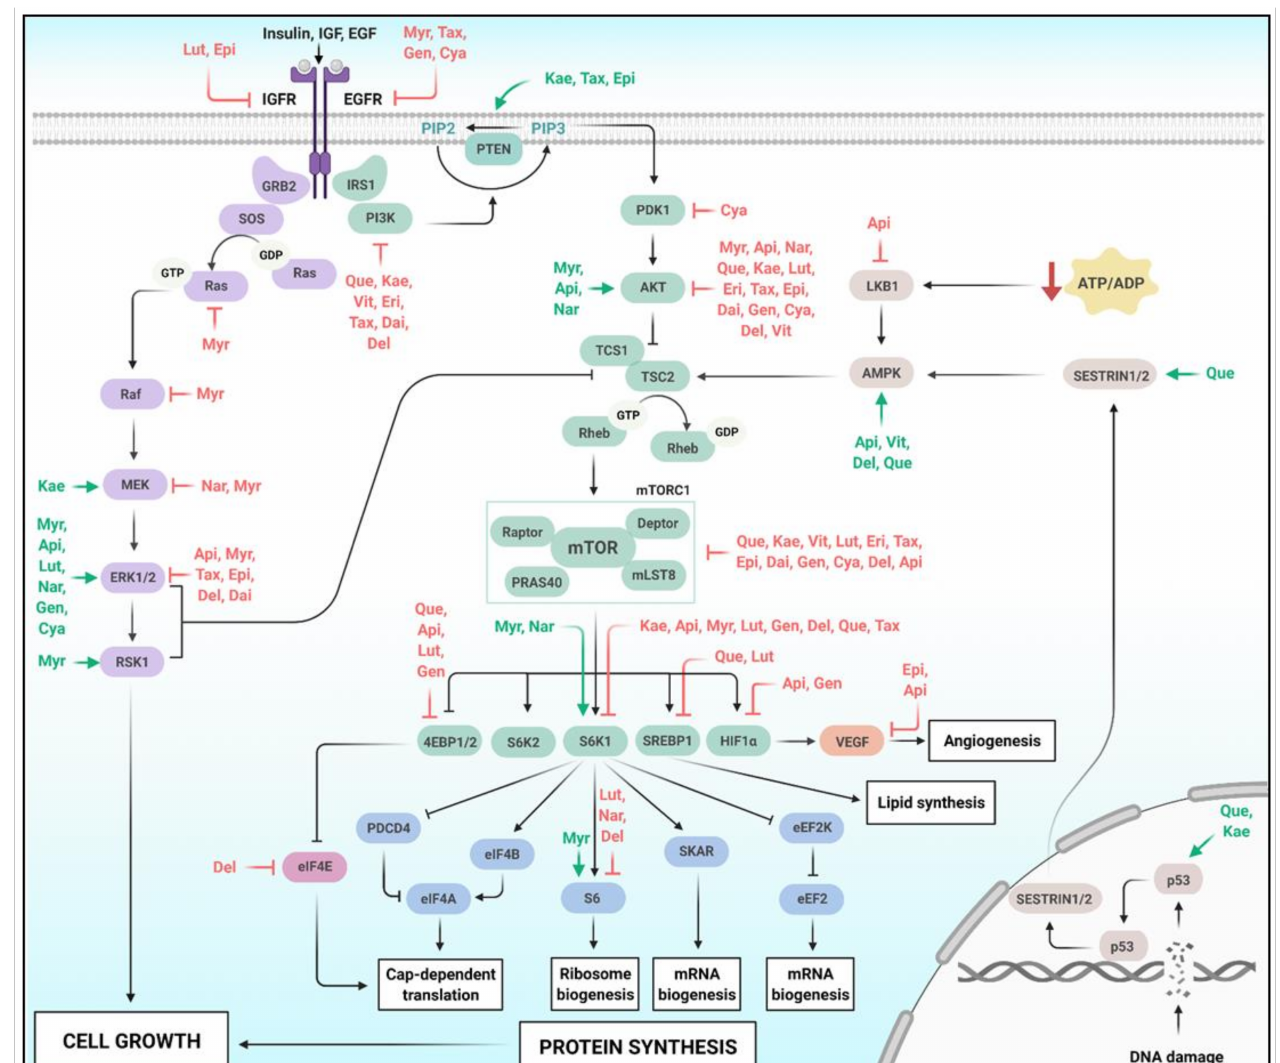
Figure 4. Flavonoids modulate growth pathways in cancer. Most of the flavonoid compounds inhibit the AKT/mTOR and Ras/ERK signaling pathway, impairing especially the metabolism, proliferation, survival, growth, and angiogenesis in cancer cells. Flavonoids can inhibit the response of the tyrosine kinase receptors (RTKs), initially controlling the upstream signaling cascade. The signaling can bifurcate in two main pathways: the Ras/ERK and the AKT/mTOR signaling. The Ras/ERK signaling, which is important in tumor progression, can be both negatively and positively regulated by flavonoids. In the AKT/mTOR pathway, one of the primary stages of signaling is the conversion of PIP2 to PIP3. This conversion can be inhibited by some flavonoids by inhibiting their converter, PI3K, or by stimulating the reverse conversion of PIP3 to PIP2 through PTEN, known as a tumor suppressor. Although some compounds stimulate AKT, probably through a feedback loop, most flavonoid compounds can inhibit AKT, preventing the activation of mTOR and, consequently, its effectors. The compounds directly inhibit mTOR, in addition to inhibiting 4EBP1/2 and S6K1, proteins that control especially the translation initiation and ribosomal and mRNA biogenesis. The compounds also stimulate p53, which targets SESTRIN 1/2, to inhibit the AKT/mTOR pathway by stimulating AMPK. mTOR signaling also controls lipid synthesis and angiogenesis, which can be both inhibited by flavonoids. These inhibitory regulations direct the cells to inhibition of cancer progression. Epi: Epigallocatechin, Kae: Kaempferol; Myr: Myricetin; Que: Quercetin; Api: Apigenin; Gen: Genistein; Dai: Daidzein; Lut: Luteolin; Nar: Naringenin; Tax: Taxifolin; Eri: Eriodictyol; Vit: Vitexin. Original figure made for this review using the Biorender